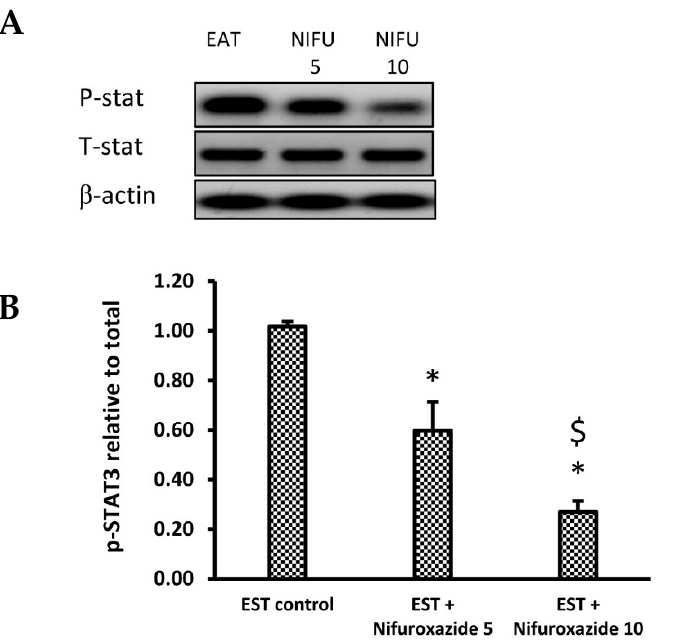
Figure 6. Western blot analysis for phosphorylated and total STAT3. ( A ) photomicrograph repre- senting the Western blot results for the selected proteins in the EST group ( 1 ), EST + Nifuroxazide (5 mg/kg) ( 2 ) and EST + Nifuroxazide (5 mg/kg) (3). ( B ) Column chart for phosphorylated STAT3 relative to total STAT3. First, both proteins were normalized to the tumor β –actin level, and then, the relative phosphorylation was calculated. Data are mean ± S.D. and compared at P less than 0.05. * Versus the EST control, $ Versus the EST + Nifuroxazide (5 mg/kg) group.